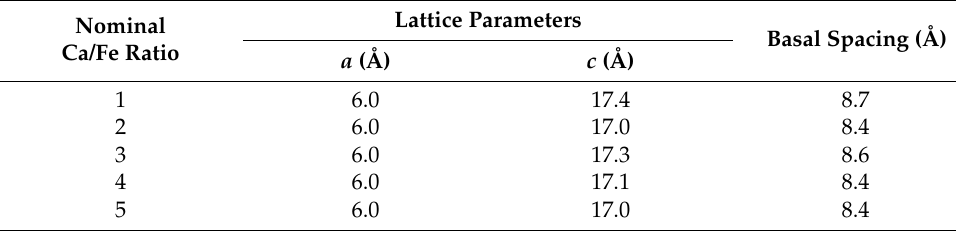
Figure 1. XRD patterns for Ca – Fe LDHs with various nominal Ca/Fe ratios of ( a ) 1, ( b ) 2, ( c ) 3, ( d ) 4, and ( e ) 5. * stands for the Ca(OH) 2 impurity. Table 1. Structural parameters of the synthesized materials.